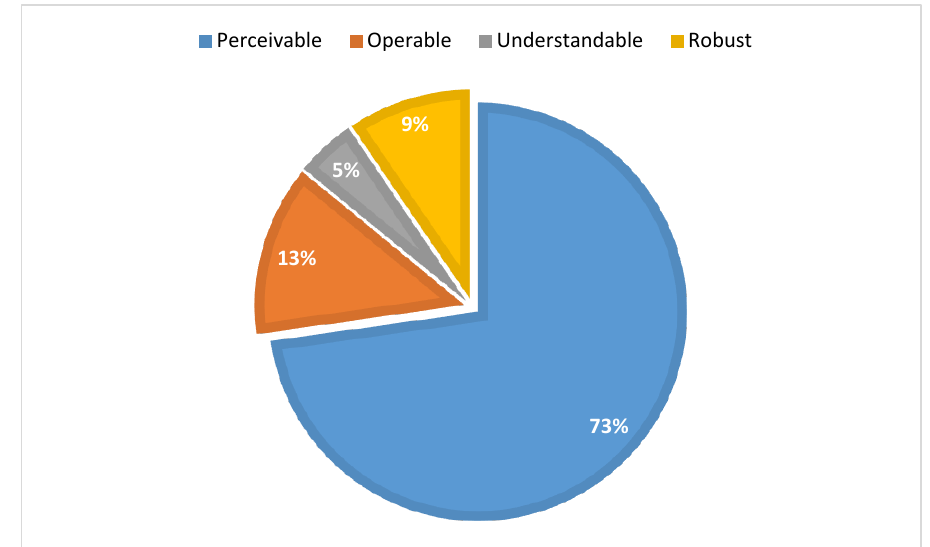
Figure 5. Overall comparison of the violated principles.